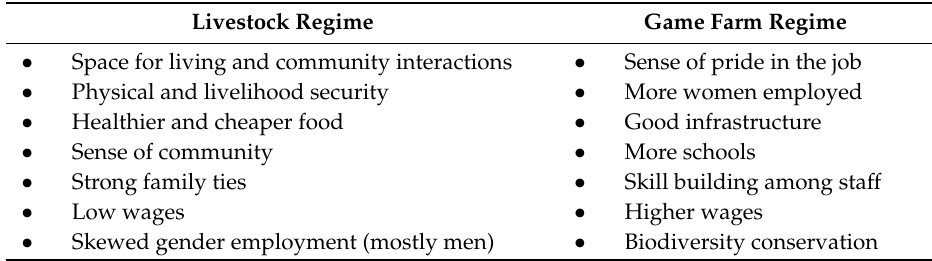
Table 2. Comparison of the key benefits and costs of livestock farming compared to game farming in the Amakhala game reserve, as perceived by farmworkers and